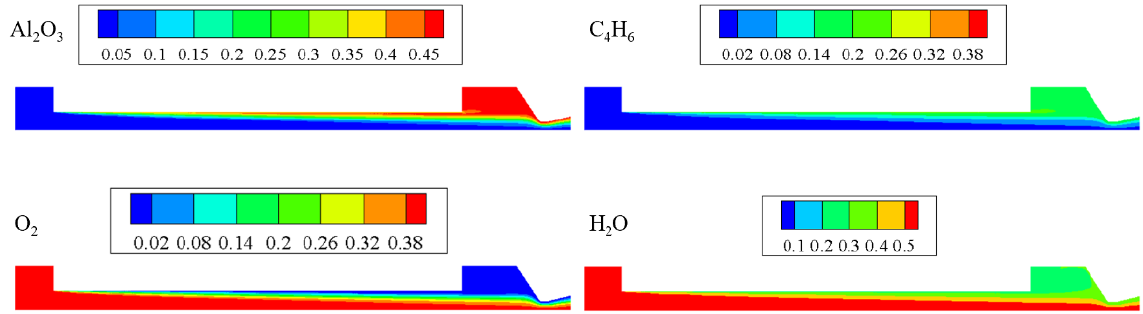
Figure 13. Mass fraction of four species in this HRM.